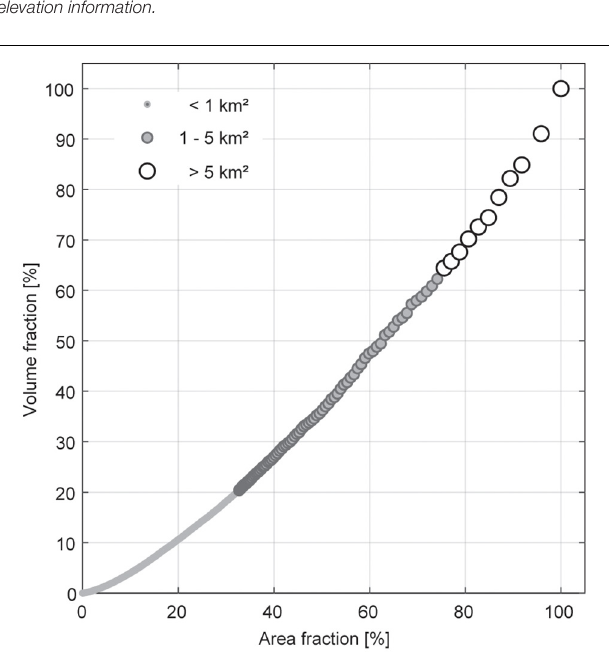
FIGURE 7 | Cumulative volume fraction of the total glacier volume for all glaciers of GI 3 sorted by glacier area, also presented as cumulative